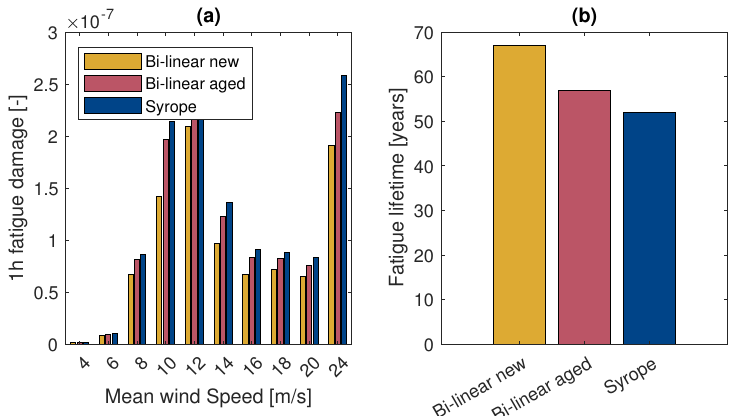
Figure 11. ( a ) Time series of the surge decay test. ( b ) Estimated natural period as function of surge amplitude.